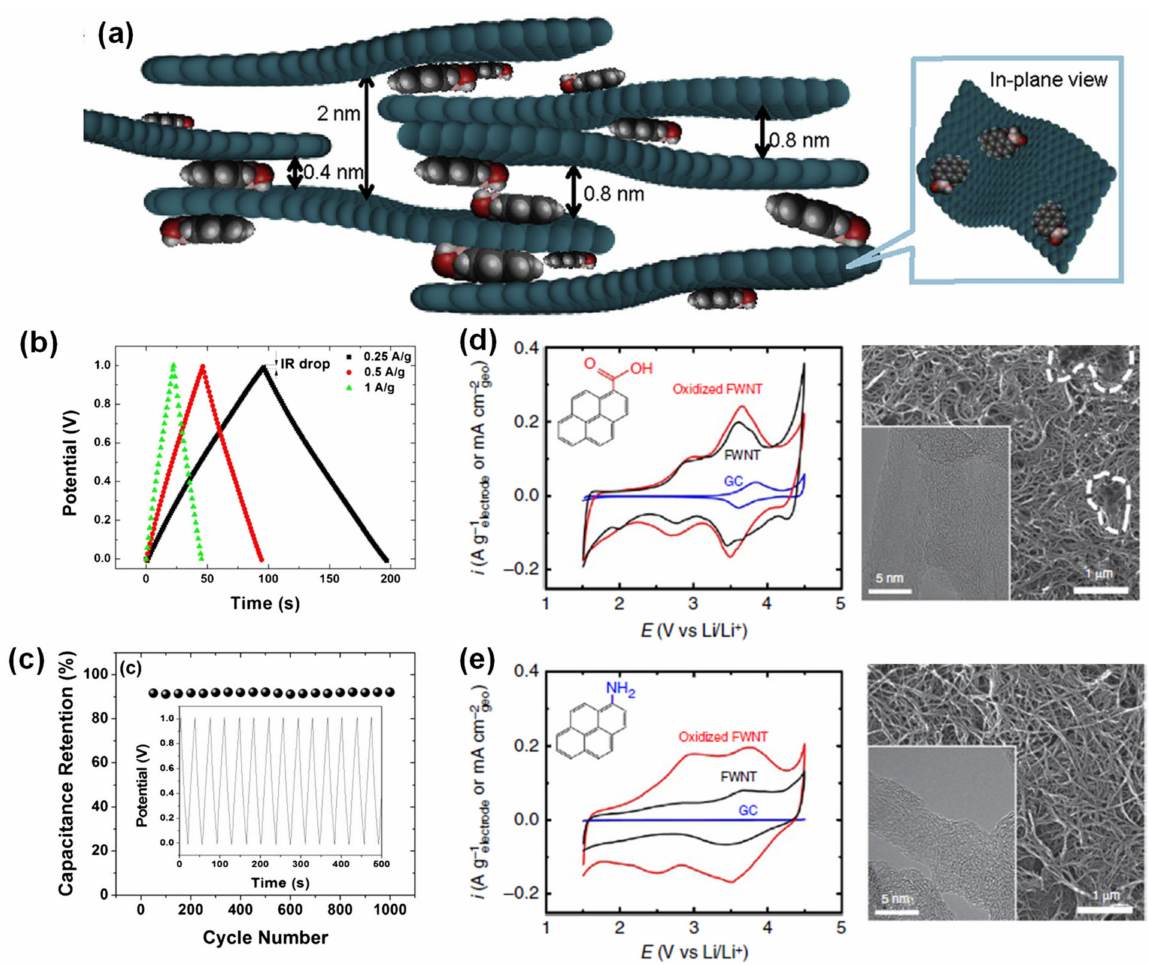
Figure 12. ( a ) Representation of pyrene intercalated between graphene nanosheets, ( b , c ) GCD curves at various current density and capacitance retention of the pyrene graphene composite, ( d , e ) CV profiles of COOH and NH 2 -pyrene on FWCNT at 1 mV/s and their corresponding SEM images. Reproduced with permission from Refs.